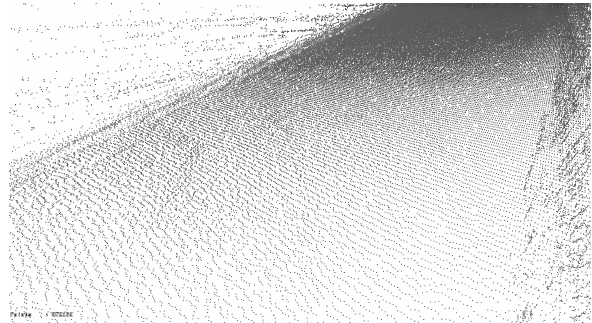
Figure 12: Reconstructed point